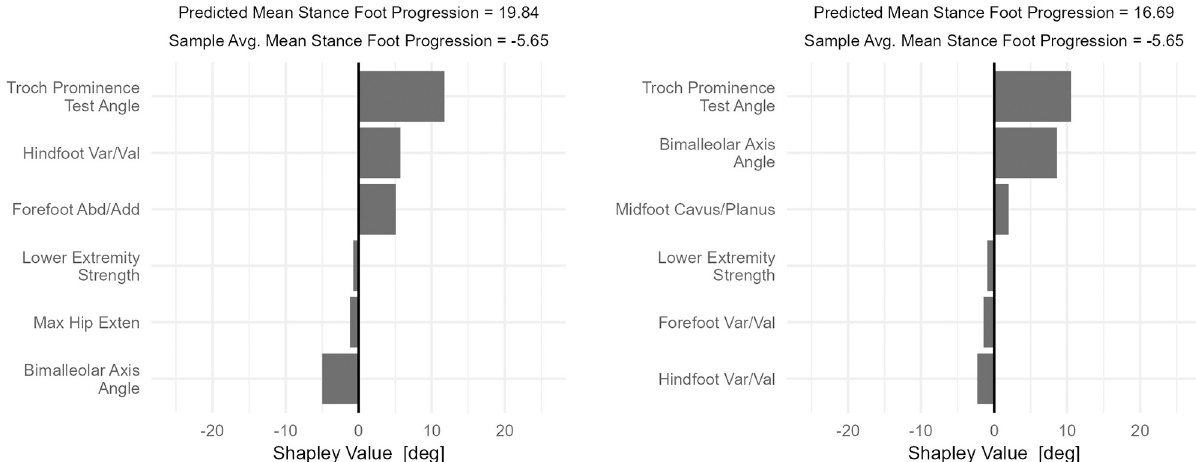
Fig 4. Case studies of Structure and Function effects on mean stance foot progression. The top row shows patients with significant in-toeing. On the top-left, the primary cause is excess femoral anteversion, with additional contributions from hindfoot varus and forefoot adduction. On the top-right femoral anteversion and tibial torsion both contribute. The bottom row shows patients with significant out-toeing. On the bottom left, external tibial torsion and forefoot deformity cause the out-toeing. On the bottom right, both femoral retroversion and external tibial torsion contribute meaningfully, along with forefoot